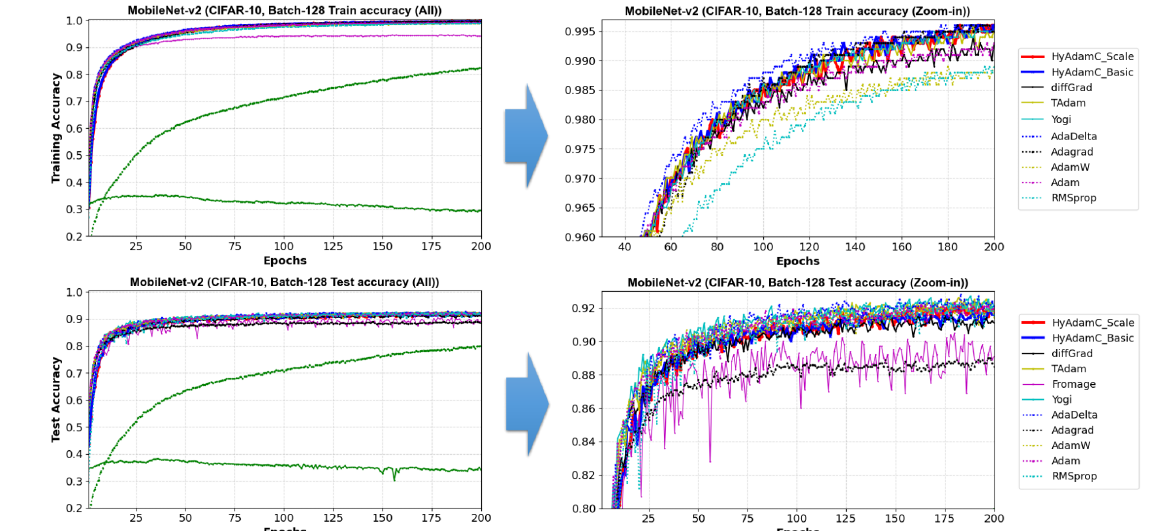
Figure 25. The training and test accuracy curves of the MobileNet-v2 trained by HyAdamC and other optimization methods in the CIFAR-10 image classification tasks. In this figure, the plots in the left side shows the training and test curves of all compared methods. On the other hand, ones in the right side illustrates the plots in which a range of the y-axis of the left plots is zoomed